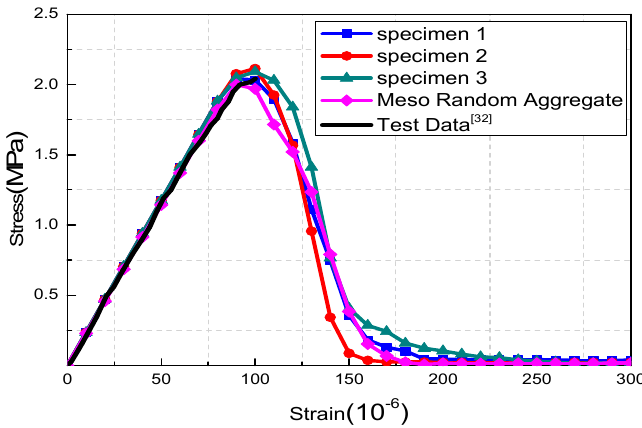
Figure 9. Uniaxial tensile stress–strain curve of parallel model. Table 2. Numerical simulation results data.